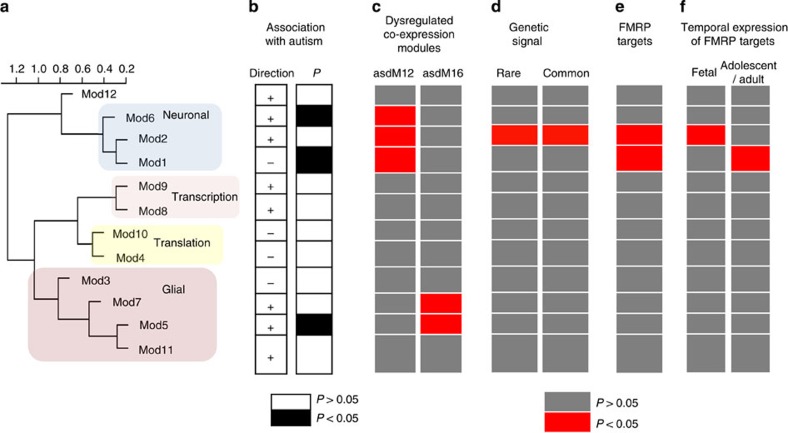
Weighted gene correlation network analysis identifies 12 co-expression modules.(a) Dendogram of 12 co-expressed modules, with major cell type/function enrichment noted (Supplementary Data 12,13a–k). Mod12 was not significantly enriched for any cell type or GO terms. (b) Disease association of each module, represented by each module’s first principal component (eigengene). Three co-expression modules are associated with autism with nominal significance (black), with mod5 significant after multi-test correction (P<9.64 × 10−4; Supplementary Data 11). A positive (+) sign indicates upregulated gene expression in autism cases. (c–f) Enrichment analysis for gene lists compiled from the literature (Supplementary Data 7,12). (c) Individual dysregulated co-expression modules in autism brains identified by Voineagu et al.10 are captured by multiple co-expression modules in the current study, allowing for refinement of the signal associated with autism. (d) Genes with known common and rare de novo variants associated with autism are enriched only for mod2, which does not show differential expression. (e) FMRP targets identified by Darnell et al.35 are enriched in neuronal co-expression modules. (f) FMRP targets were split into fetal and adult/adolescent expression patterns36, and are captured by different co-expression modules. Red, P<0.05; grey, P>0.05.